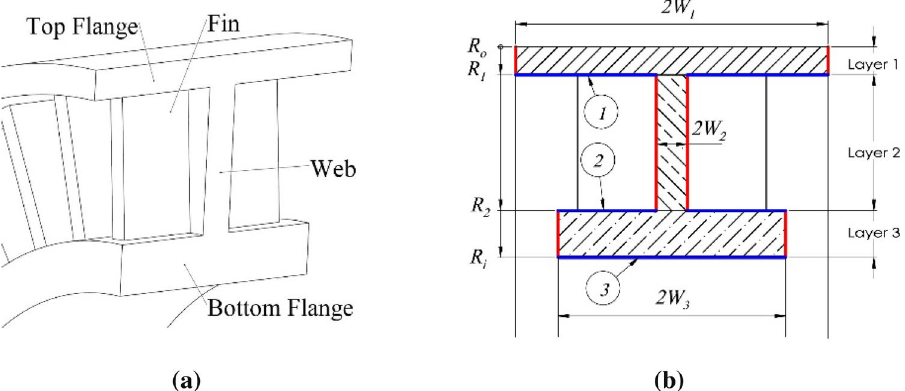
Figure 5. Structure of a general pulley.